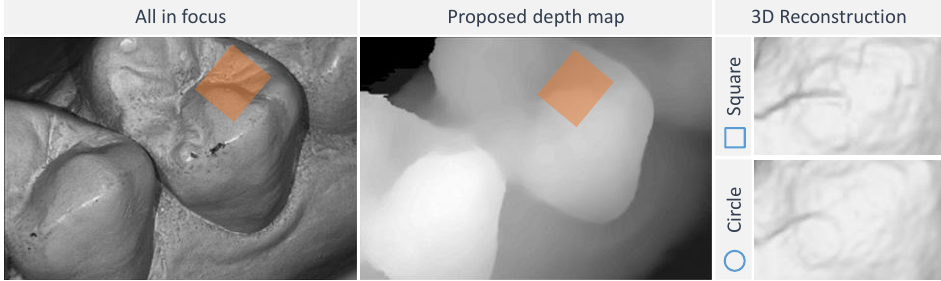
Figure 2. From left to right: all-in-focused image, depth map, and 3D reconstruction results using circle and square windows (highlighted part zoomed-in). Three-dimensional reconstruction result shows that circle window produces less artifacts.